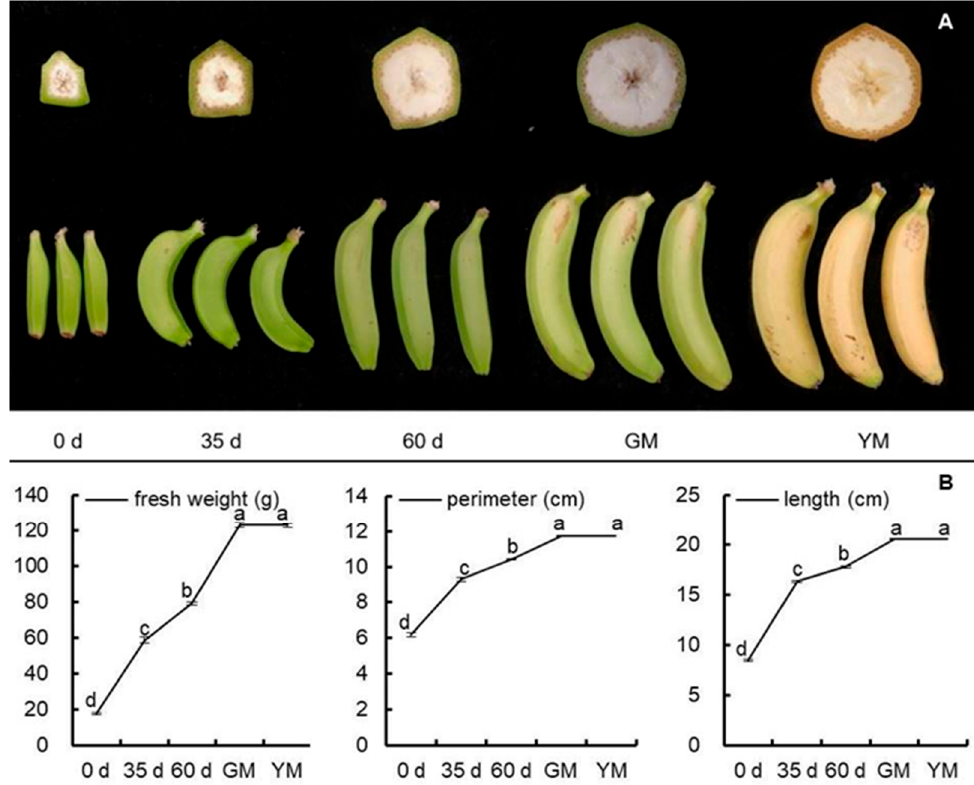
Figure 1. Changes in appearance and size of banana ( Musa spp. AAA) fruits during development and ripening. ( A ) Fruit appearance and cross-section. ( B ) Fruit fresh weight, perimeter, and length. Each treatment consisted of three biological replicates. Data represent an average of three replicates ± SE. Values followed by the different letters represent significant differences using Duncan’s multiple range test at p < 0.05 after angular transformation of the data. 0 d: fruits just emerging from the bunch; 35 d: 35 day-old fruits; 60 d: 60 day-old fruits; GM: green matured fruits (at harvest, 85 day-old fruits); YM: yellow matured fruits (6 d after ethylene treatment).